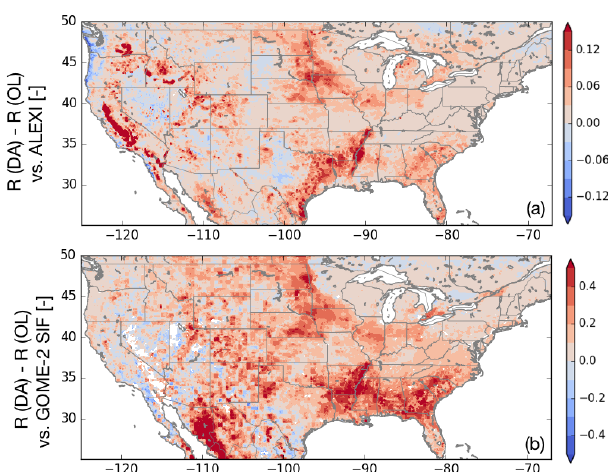
Figure 6. Changes in the skill of simulated evapotranspiration and GPP as a result of assimilating L-band VOD estimates from SMAP. Panel (a) represents the changes in R of evapotranspira- tion (expressed as R (DA) − R (OL)), using ALEXI data as the ref- erence. Panel (b) shows the changes in R of modeled GPP using solar-induced fluorescence data from GOME-2 as the reference, ex- pressed as R (DA) − R (OL). The warm colors represent improve- ments from DA and cool colors represent degradations resulting from